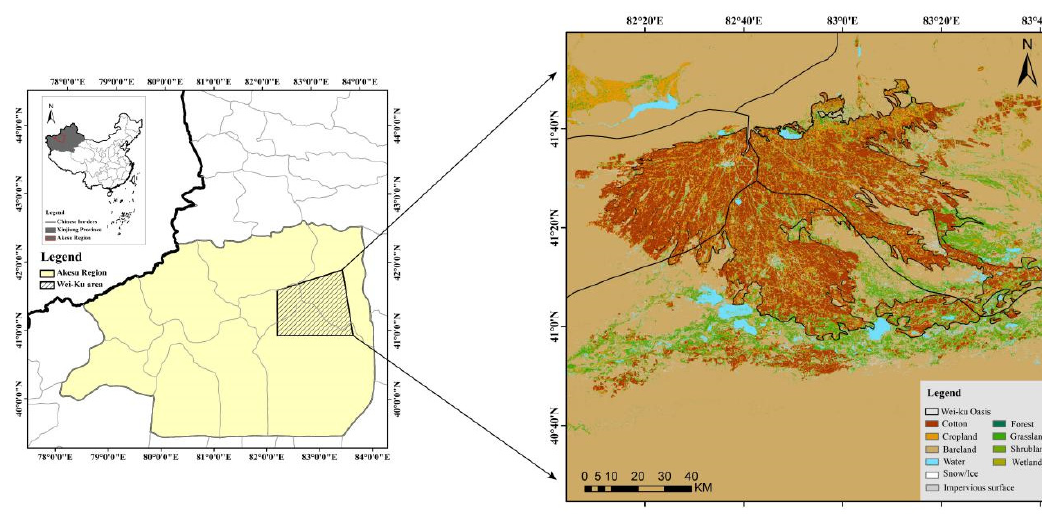
Figure 1. The geographical location of the study area.